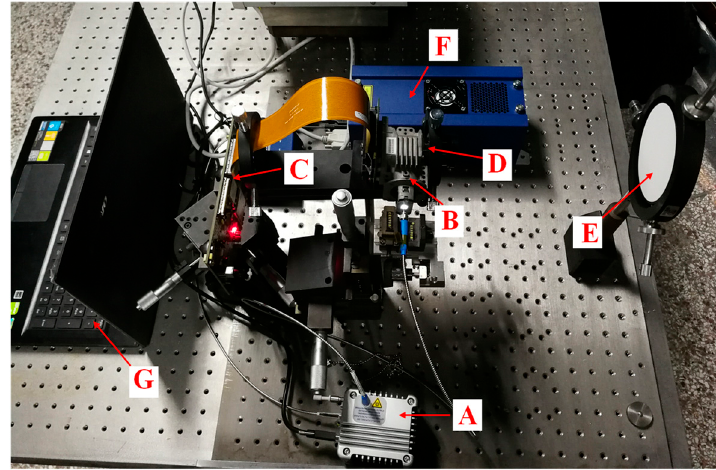
Figure 2. Digital grayscale generation equipment (DGGE).